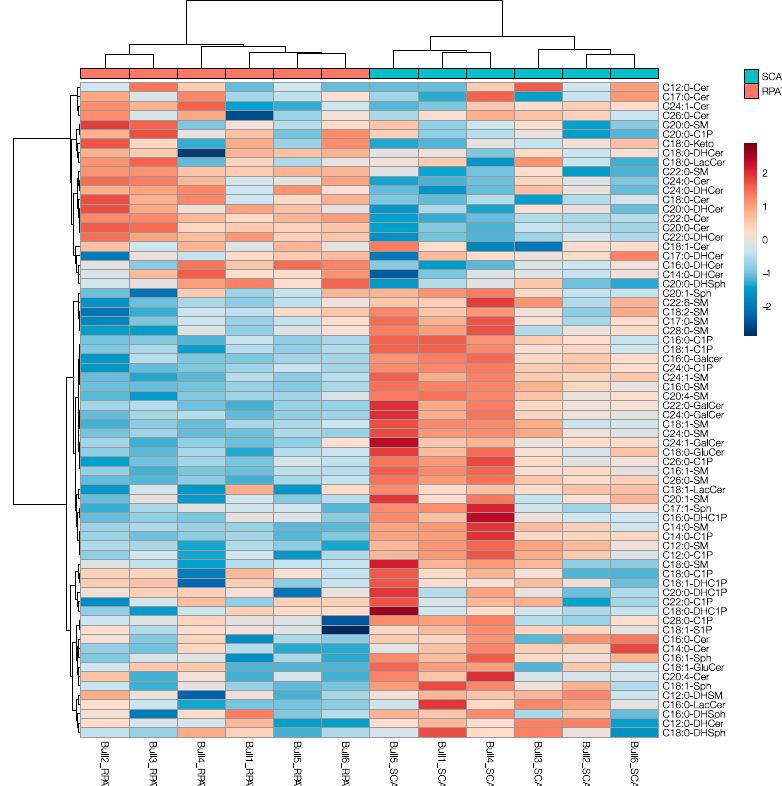
Figure 3. The heatmap with dendrograms visualizing the individual variability between the concentration of various sphingolipids in SCAT and RPAT of Holstein bulls. Data were log-transformed and Pareto-scaled. Samples (bulls) and features (metabolites) were clustered in Euclidean distance with the Ward algorithm.